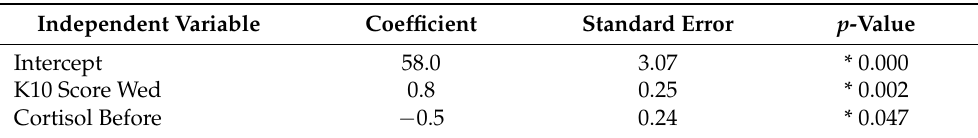
Table 5. Regression results of MASQ Wednesday scores (dependent variable), K10 Wednesday score, and saliva cortisol level before exercise (independent variables). * p <